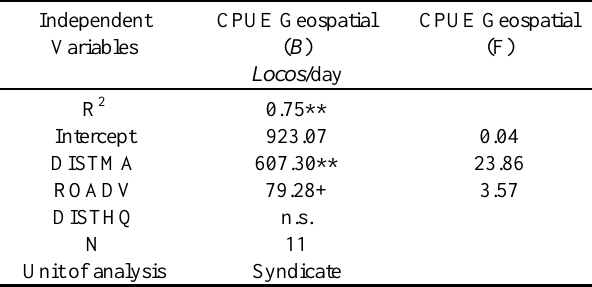
Table 2 . Regression models of catch-per-unit effort (CPUE) for geospatial models. Independent variables used in the analysis shown in column 1.